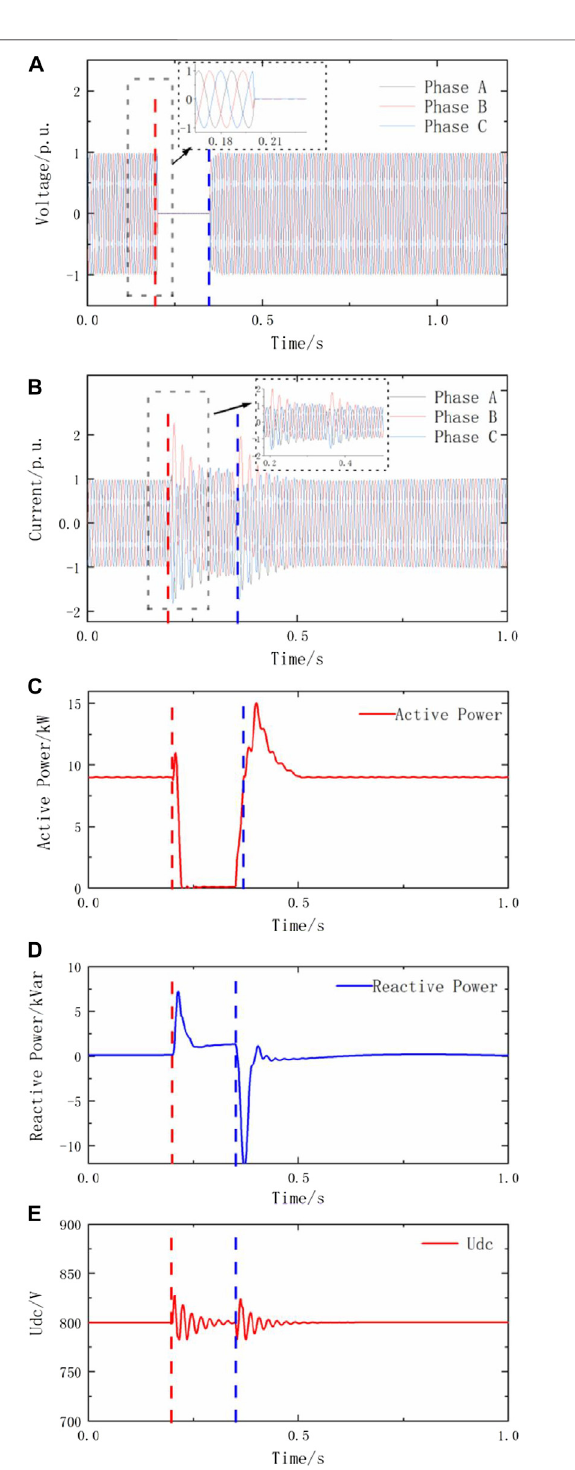
FIGURE 5 | Results of control simulation when a zero voltage drop fault occurs. (A – E) power Q and DC bus voltage U dc .